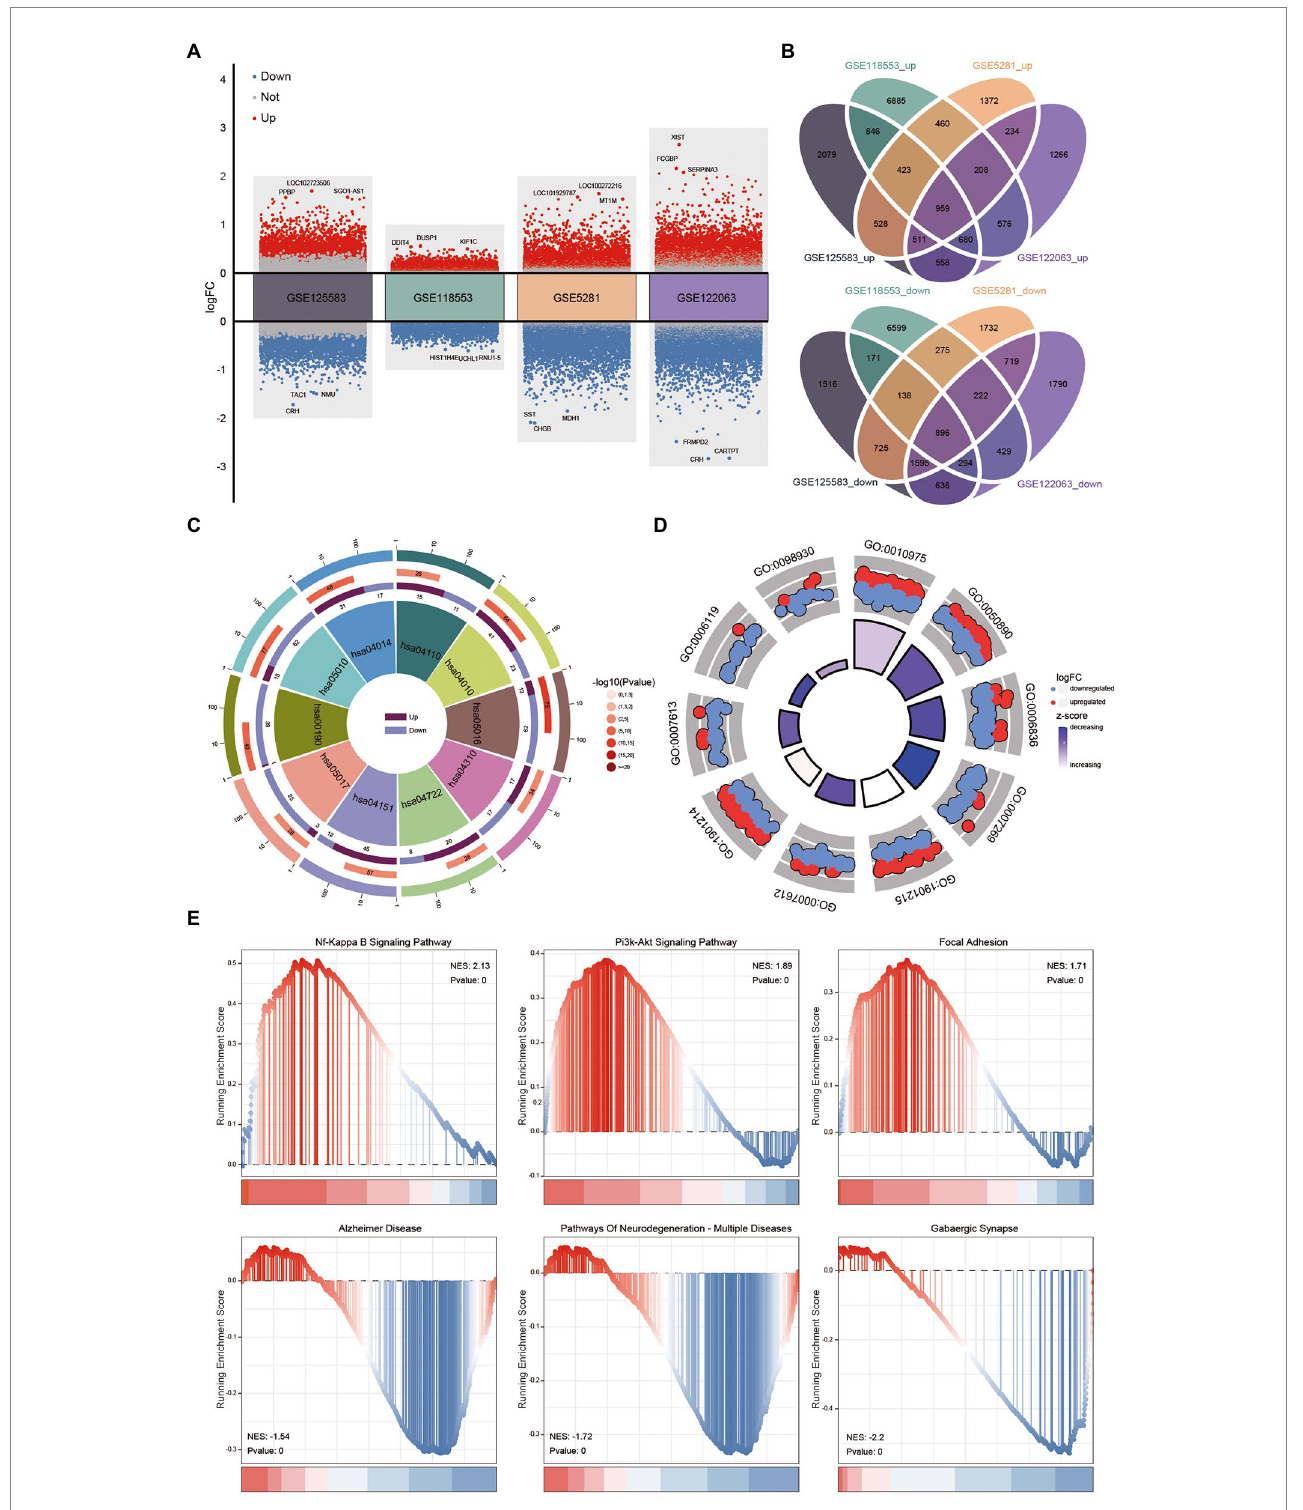
FIGURE 2 Biological function of intersected differentially expressed genes (DEGs) in Alzheimer’s disease (AD) patients and controls. (A) Up-/down-regulated DEGs of four datasets (GSE125583, GSE118553, GSE5281, and GSE122063), red indicates upregulated DEGs, blue indicates down-regulate DEGs. (B) Intersected DEGs of four datasets were obtained by Venn diagram. (C) The Kyoto Encyclopedia of Genes and Genomes pathways of intersecting DEGs. (D) Gene Ontology of intersecting DEGs were obtained using enrichment analysis. (E) Using gene set enrichment analysis to analysis the expressed profile of GSE125583. GO, gene ontology; NES, normalized enrichment